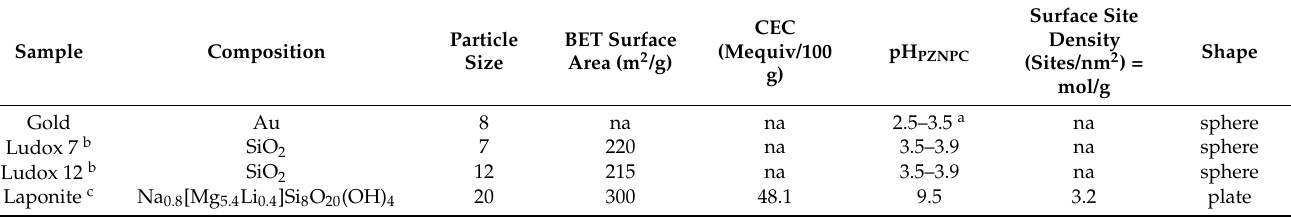
Table 1. Summary of nanoparticle